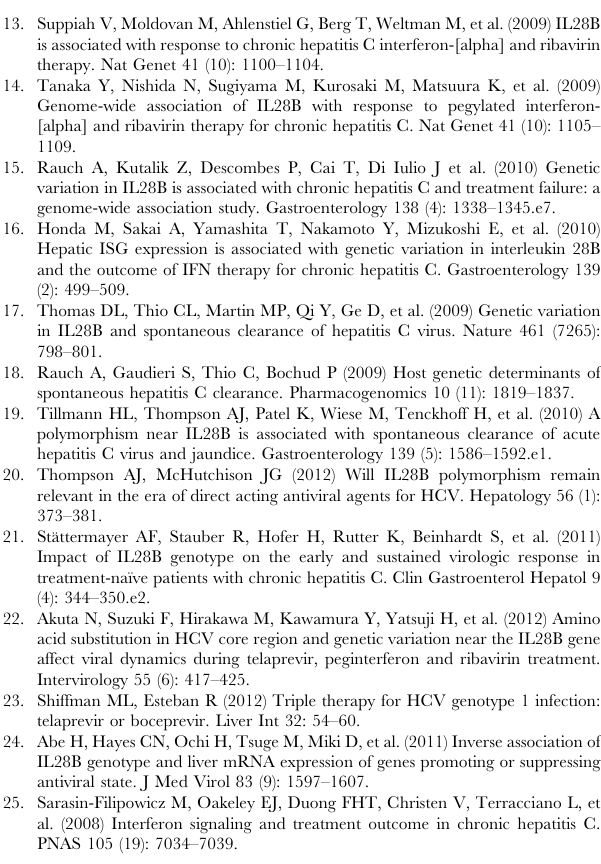
Figure S1 Association of IFNL3 variants with baseline predictors in the replication cohort. Association of the IFNL3 rs12979860 and rs8099917 genotypes with the levels of ( A) GGT (IU/mL), (B)